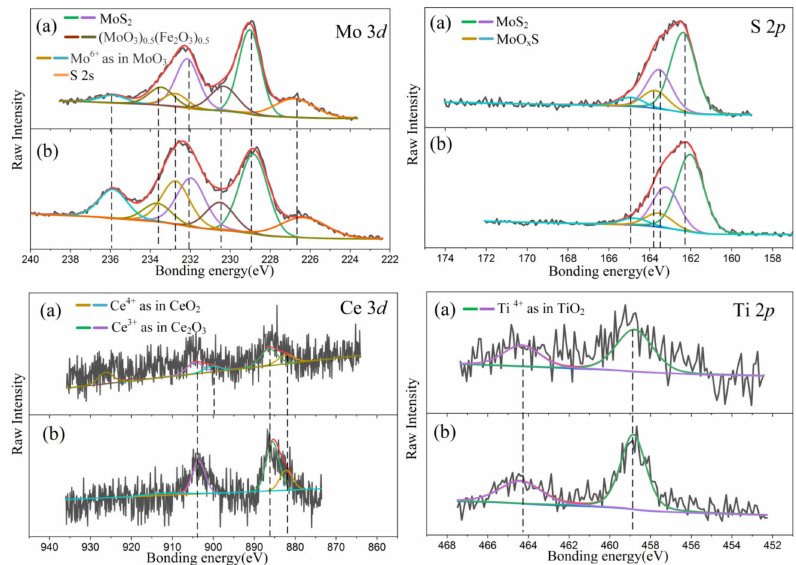
Figure 11. XPS spectra of Mo 3d, S 2p, Ce 3d and Ti 2p ( a ) 0.6 Pa, ( b ) 1.8